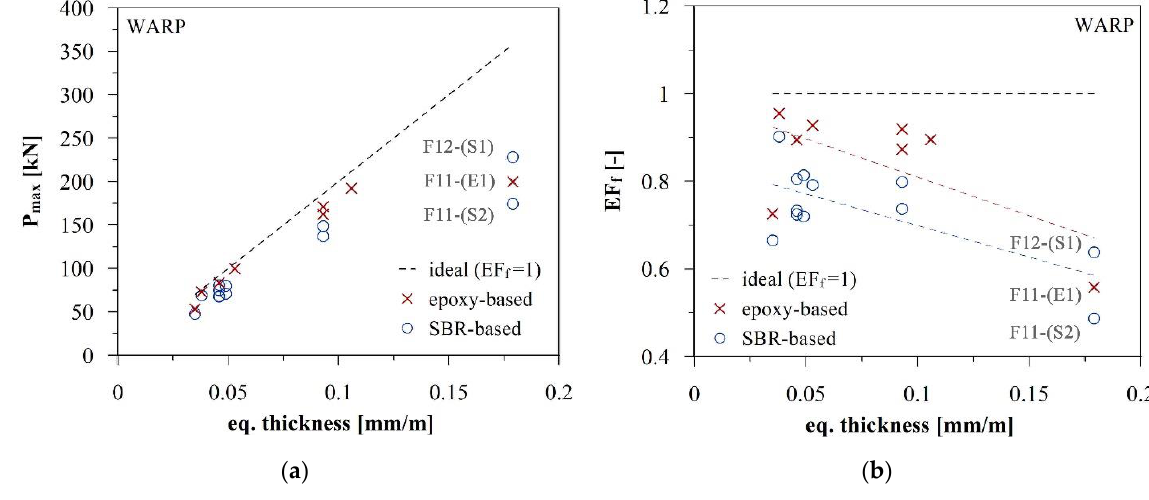
Figure 4. Average maximum load ( a ) and fabric efficiency ( b ) vs. equivalent thickness of the investigated textiles in the warp direction.